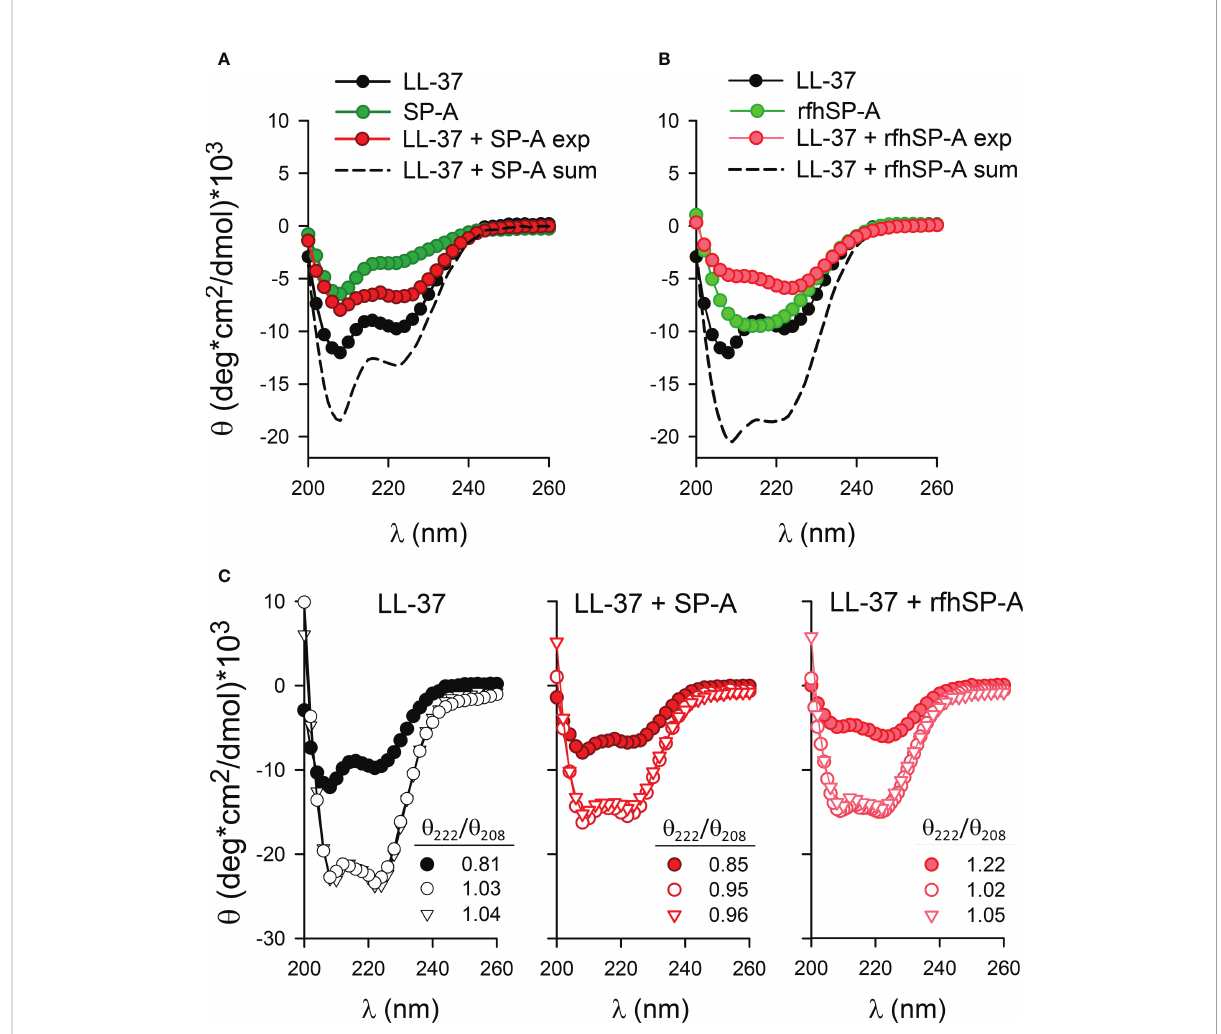
FIGURE 4 Secondary structure of LL-37, SP-A, rfhSP-A, and combinations thereof in the presence and absence of bacterial membranes. (A) The mean residue ellipticity of LL-37, SP-A, the mixture of LL-37 and SP-A proteins (denoted exp), and the sum of the individual spectrum of each protein (dashed line, denoted sum). (B) The mean residue ellipticity of LL-37, rfhSP-A, the mixture of LL-37and rfhSP-A proteins (denoted exp), and the sum of the individual spectrum of each protein (dashed line, denoted sum). (C) Changes in the molar ellipticity of LL-37, LL37+SP-A, and LL-37+rfhSP-A in the absence ( fi lled circles) and presence of lipid vesicles mimicking the bacterial inner membrane (open triangles) (BPL: POPE/POPG/CL, 67/23/10, w/w/w, 1 mg/ml) and the outer membrane of Gram-negative bacteria (open circles) composed of Re-LPS/BPL (8:2, w/w) (1 mg/ml). Mean residue 222/208 ellipticity ratios are shown. Measurements were performed at 25°C in 5mM Tris-HCl, 150mM NaCl buffer, pH 7.4. Protein concentrations were: 100 µg/ml LL-37, 75 µg/ml SP-A, and 75 µg/ml rfhSP-A. A representative experiment of three are